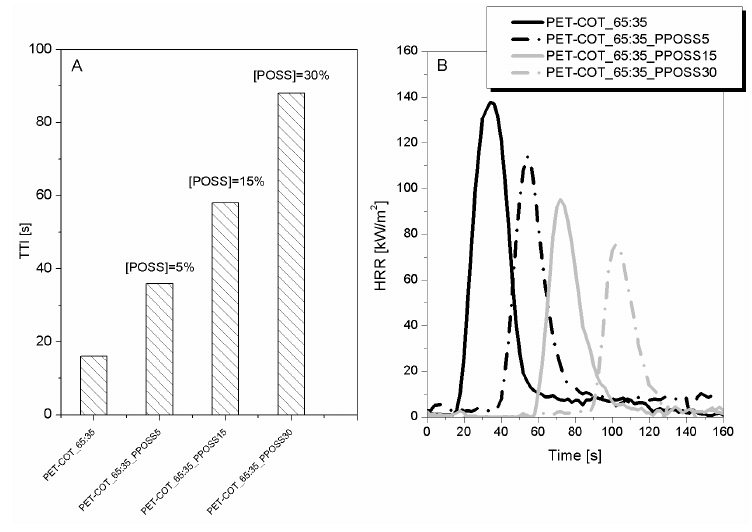
Figure 7. TTI values ( A ) and HRR curves ( B ) of PET-COT_65:35 fabrics treated with different POSS amounts and a phosphorus-based FR. Data obtained by cone calorimetry at 35 kW/m 2 .